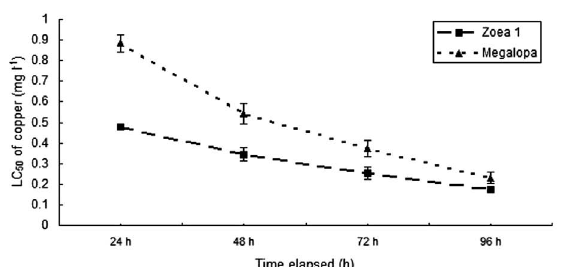
Fig. 1. – LC values (95% confidence limits) of copper versus 50 exposure time for Eriocheir sinensis zoea 1 and megalopa larvae. Values are means ±SE ( n =3).